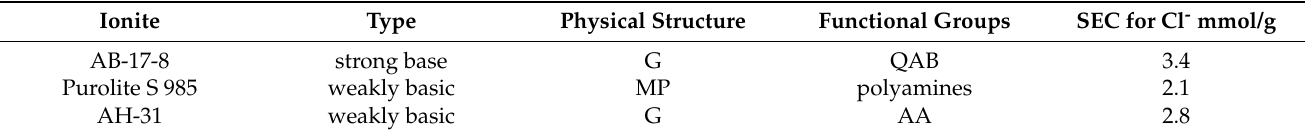
Table 1. Ion-exchange resins